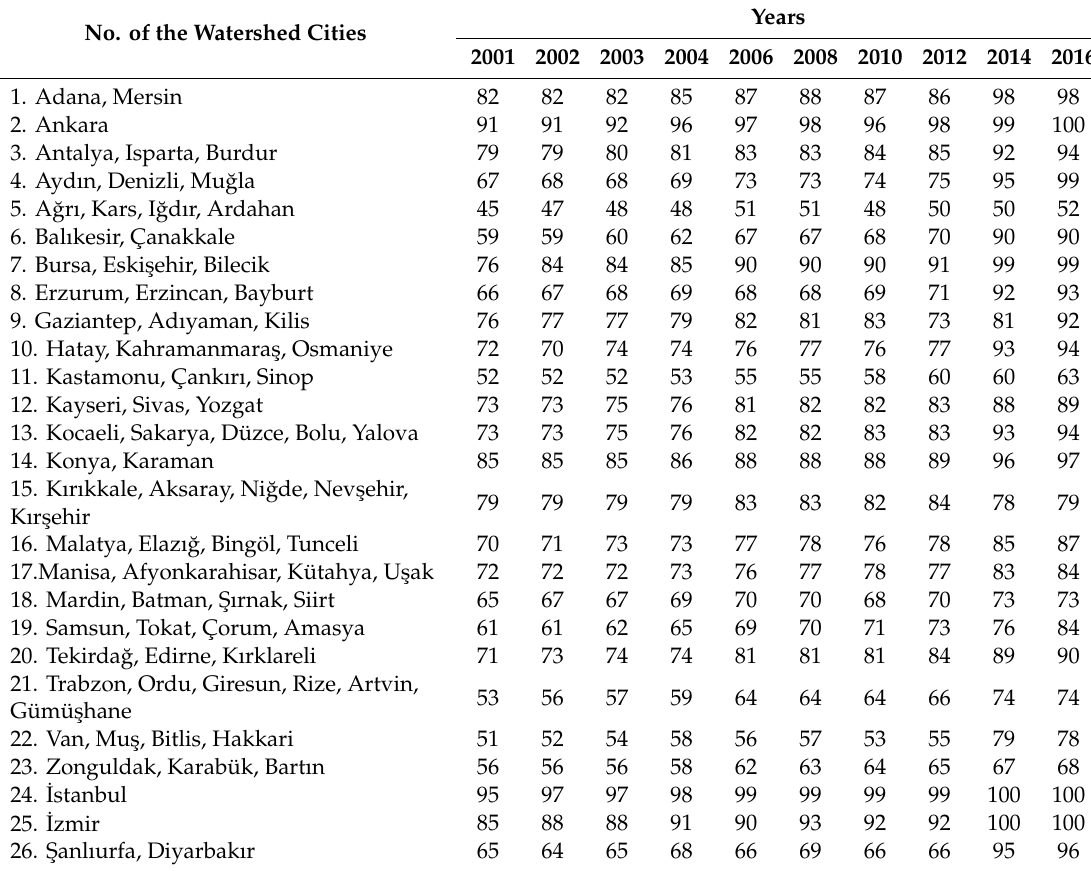
Table 1. Grouped cities of Turkey according to which watershed they benefit from and tap water consumer ratios (TWCRs) over some years (all of the numerical values presented in the table are percentages). No. of the Watershed